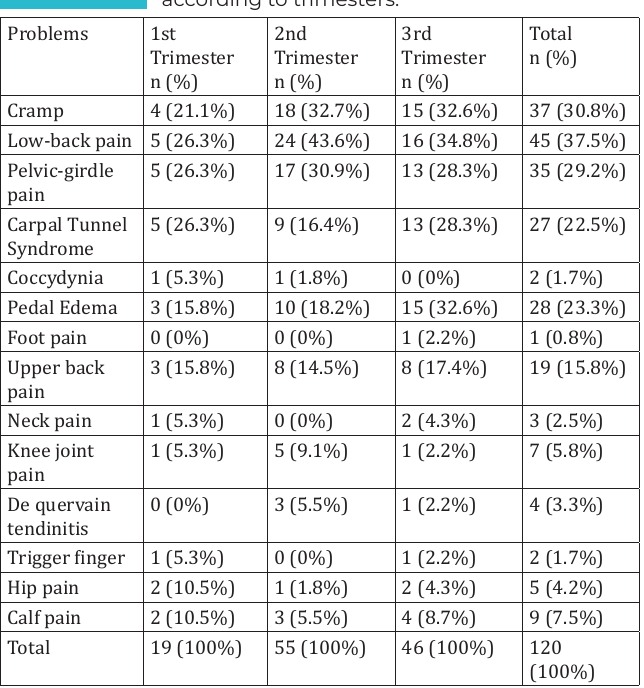
Prevalence of musculoskeletal problems according to